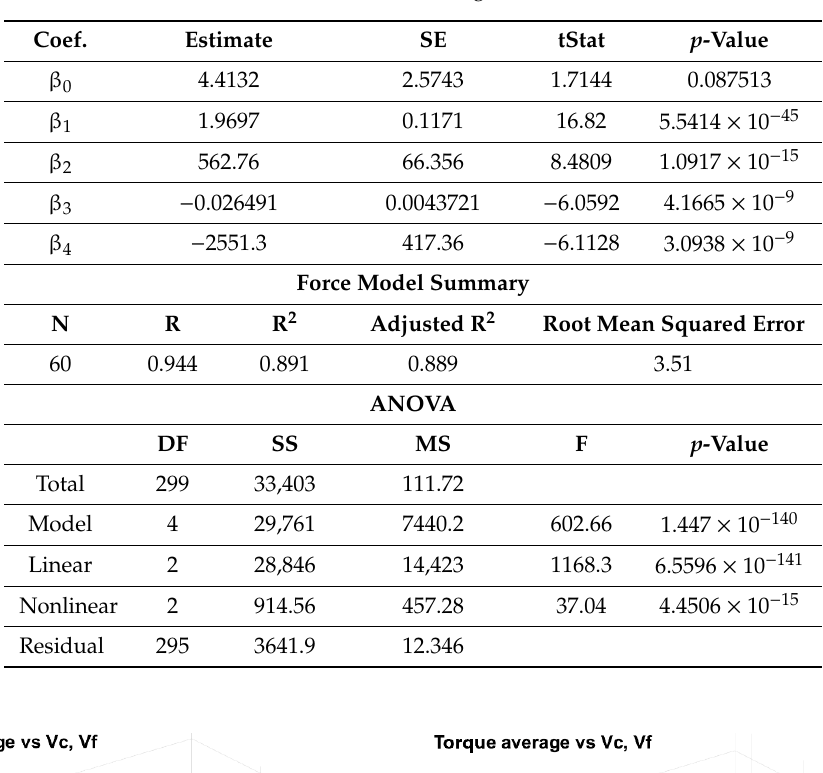
Table 4. Results of regression.